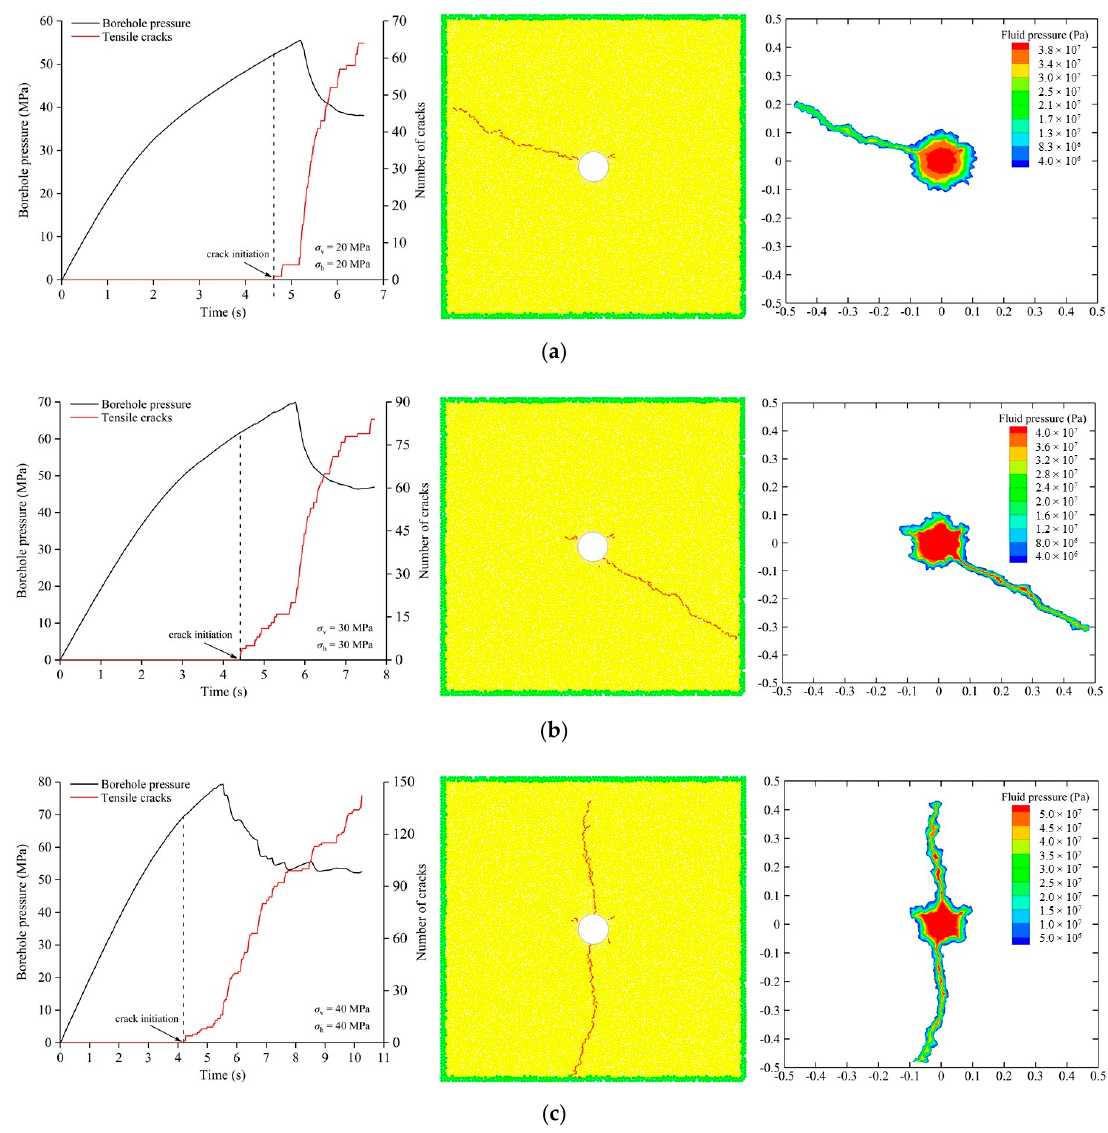
Figure 7. The representative borehole pressure histories, crack spatial distribution and corresponding fluid pressure field in the single-well fracturing under different in-situ stress conditions: ( a ) σ v = σ h = 20 MPa; ( b ) σ v = σ h = 30 MPa; and ( c ) σ v = σ h = 40 MPa.